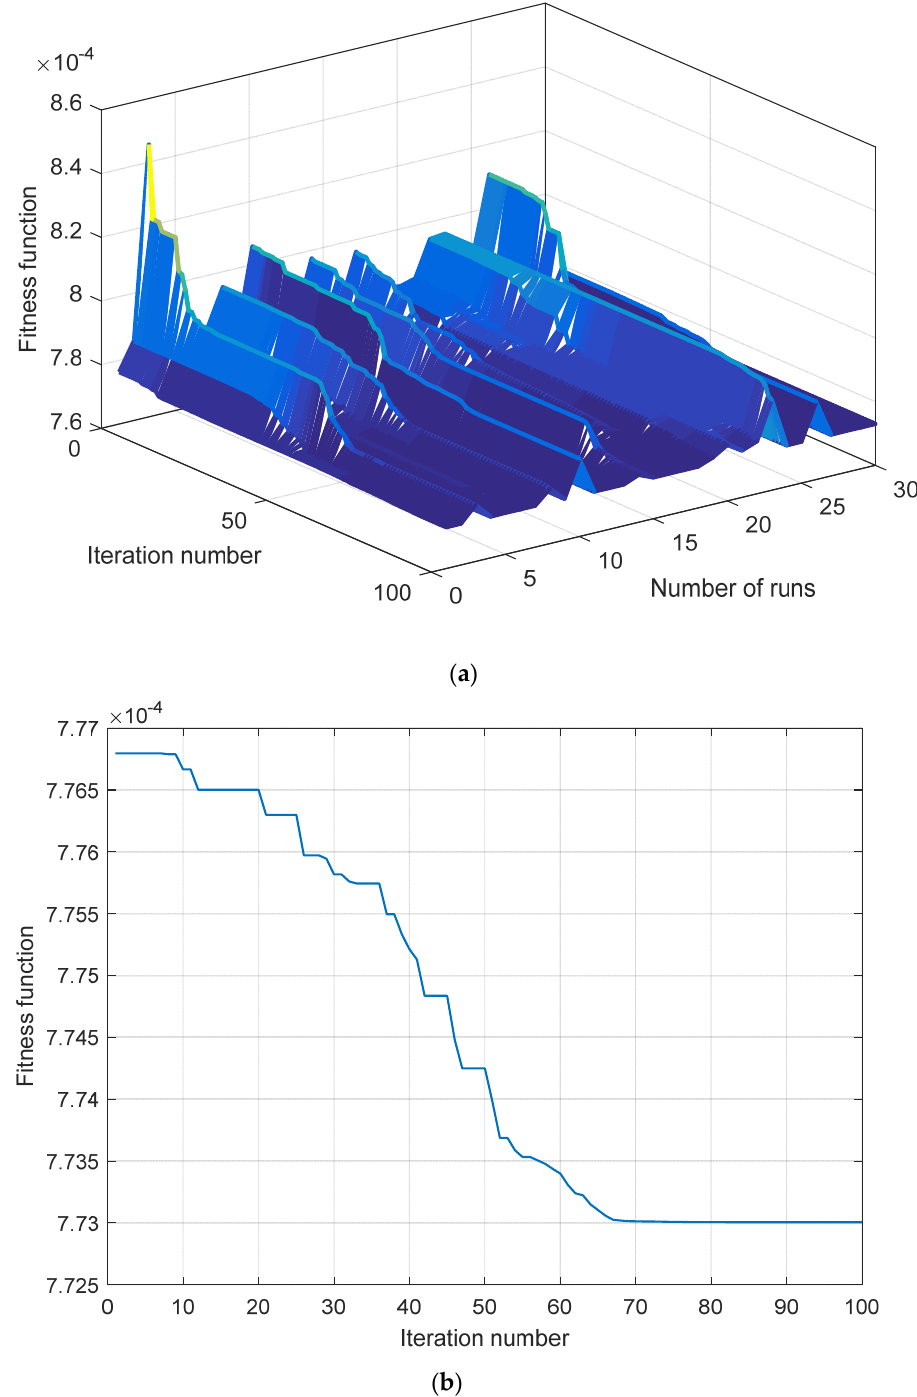
Figure 12. Proposed Algorithm 2: ( a ) fitness function for a different number of runs, and ( b ) mean fitness value versus iteration number.